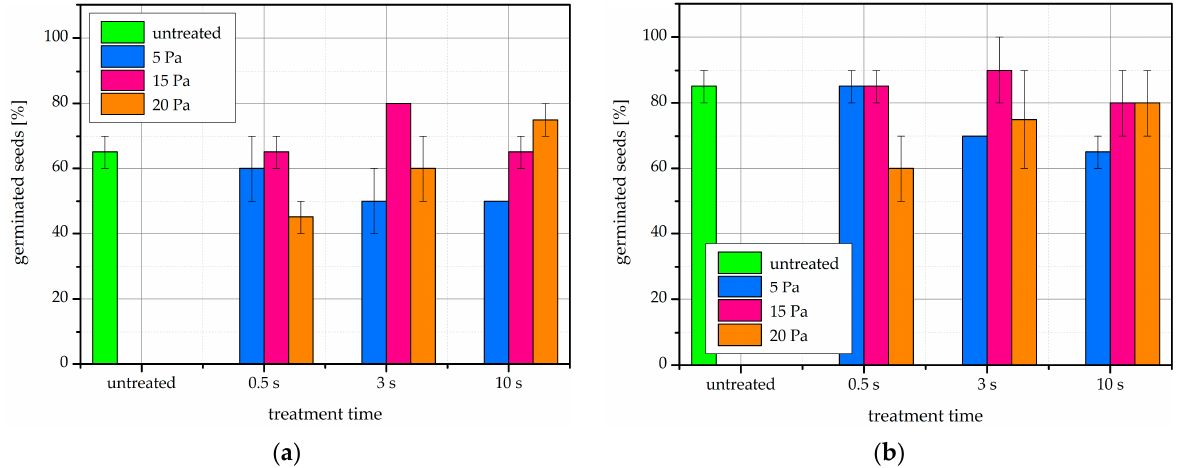
Figure 8. Germination percentage of native and plasma-treated bean seeds after ( a ) 4 days and ( b ) 7 days of incubation at germination conditions. The error bars represent standard error.